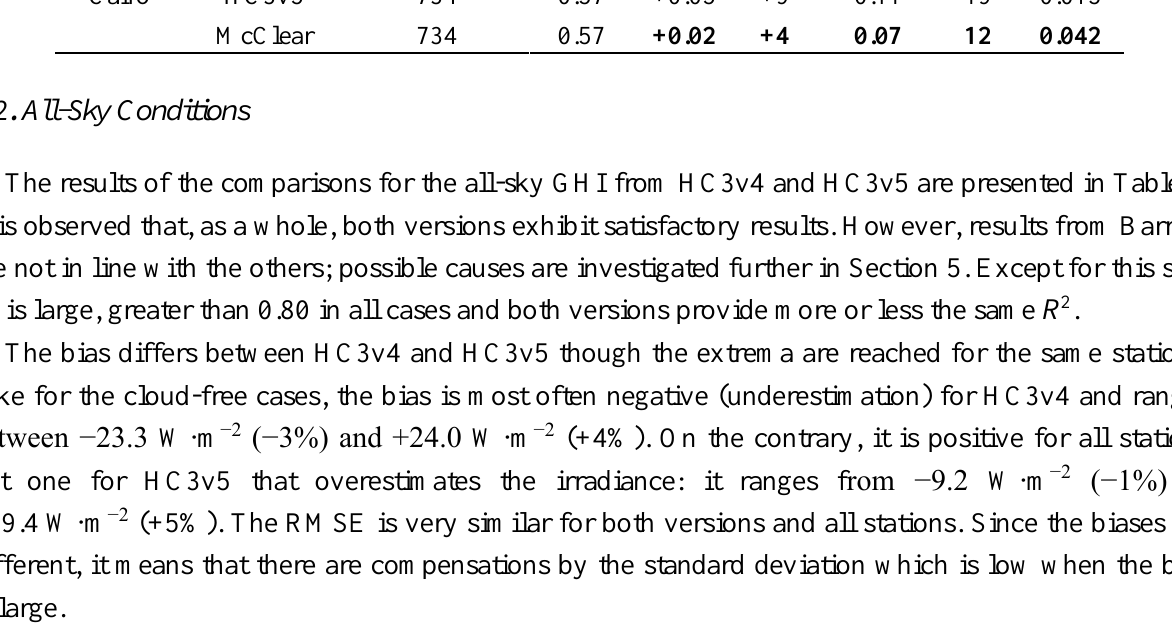
Table 6. Validation of the GHI under all-sky conditions, the best values for each station are in